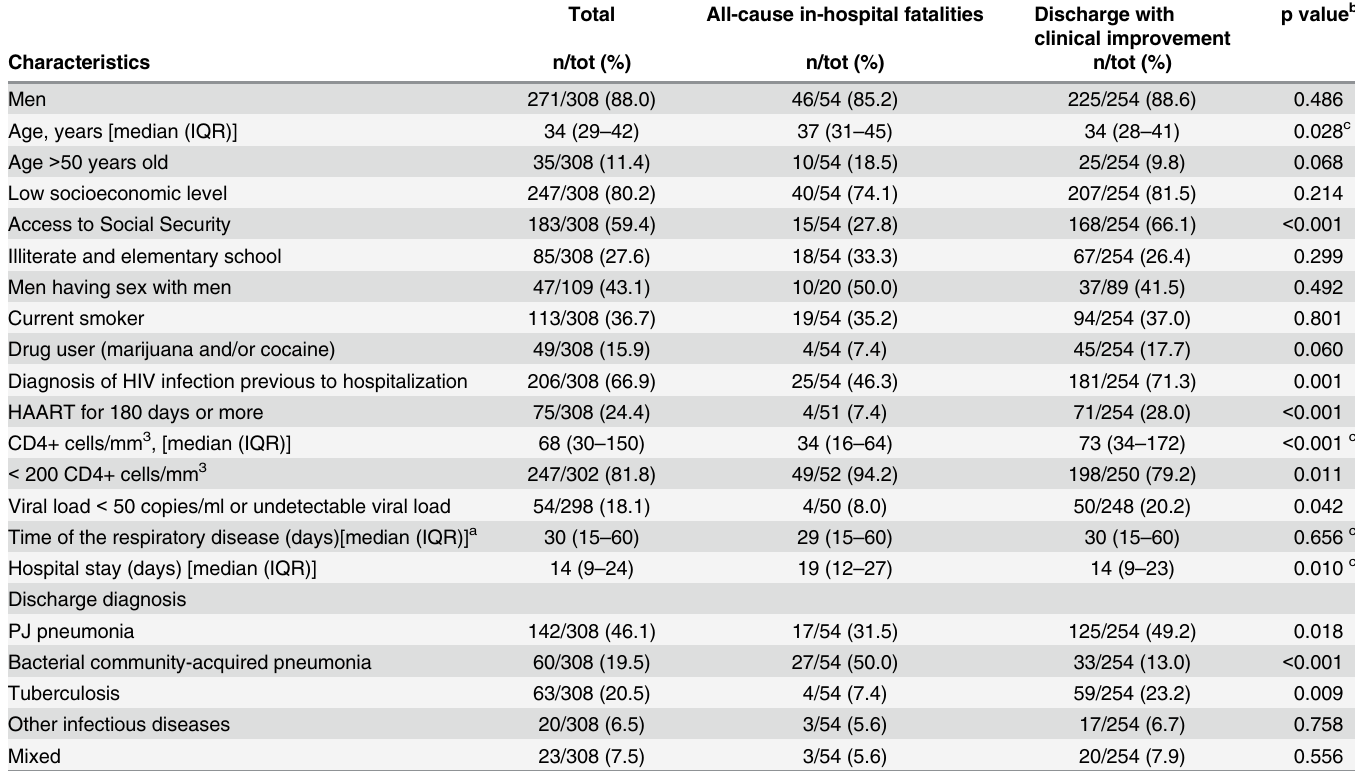
Table 3. Characteristics of HIV/AIDS patients in a specialty hospital for respiratory diseases in Mexico City, from January 2010 to December 2011, according to hospital